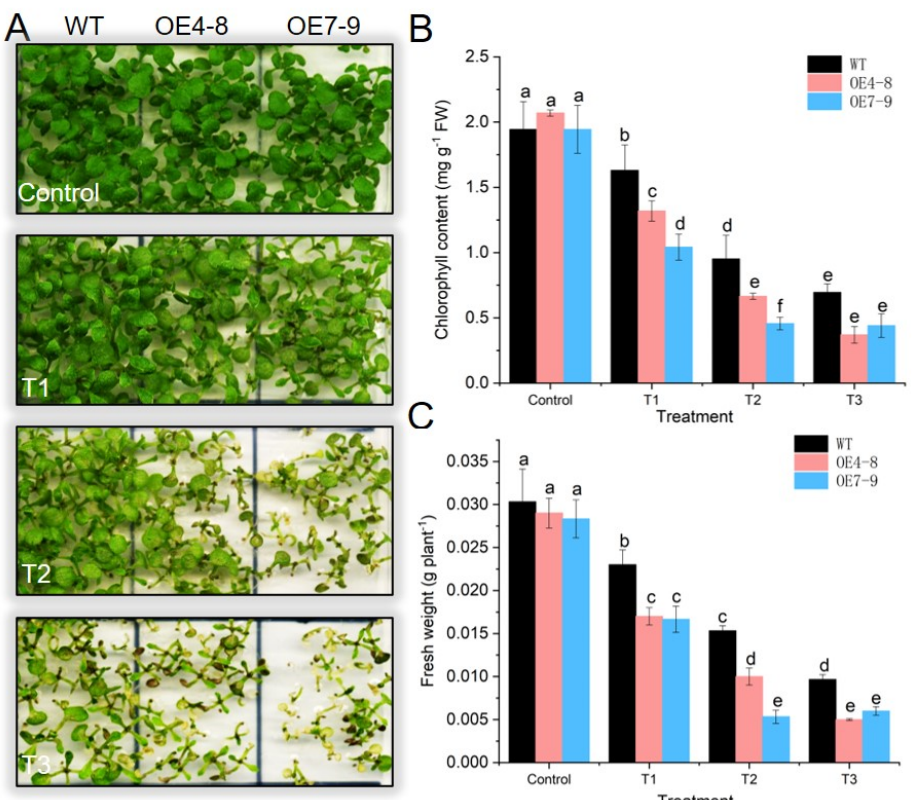
Figure 7. Overexpression of SlCML39 increases the sensitivity of seedling growth to high temperature (HT). ( A ) Phenotype of seedling growth of SlCML39 -overexpressing lines (OE4-8 and OE7-9) after HT. After germination on 1/2 MS medium for 7 days, the seedlings on plates were exposed to 45 °C for 0 min (control), 45 min (T1), 60 min (T2), and 90 min (T3), followed by recovery under standard conditions (23 °C) for 7 days. ( B ) Chlorophyll content of ( A ). ( C ) Plant fresh weight of ( A ). The bar represents the mean ± SD values of three replicates ( n = 3). According to the LSD test, the statistical differences between samples are marked with different letters ( p < 0.05).